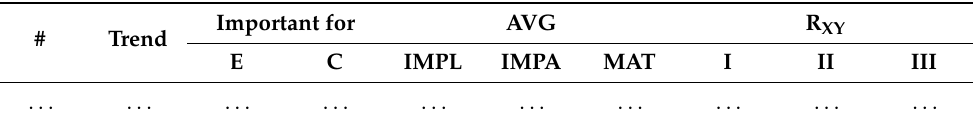
Table 3. Specific Industry 4.0 trends and their estimated impact on the development of business models based on co-production and co-creation—data presentation